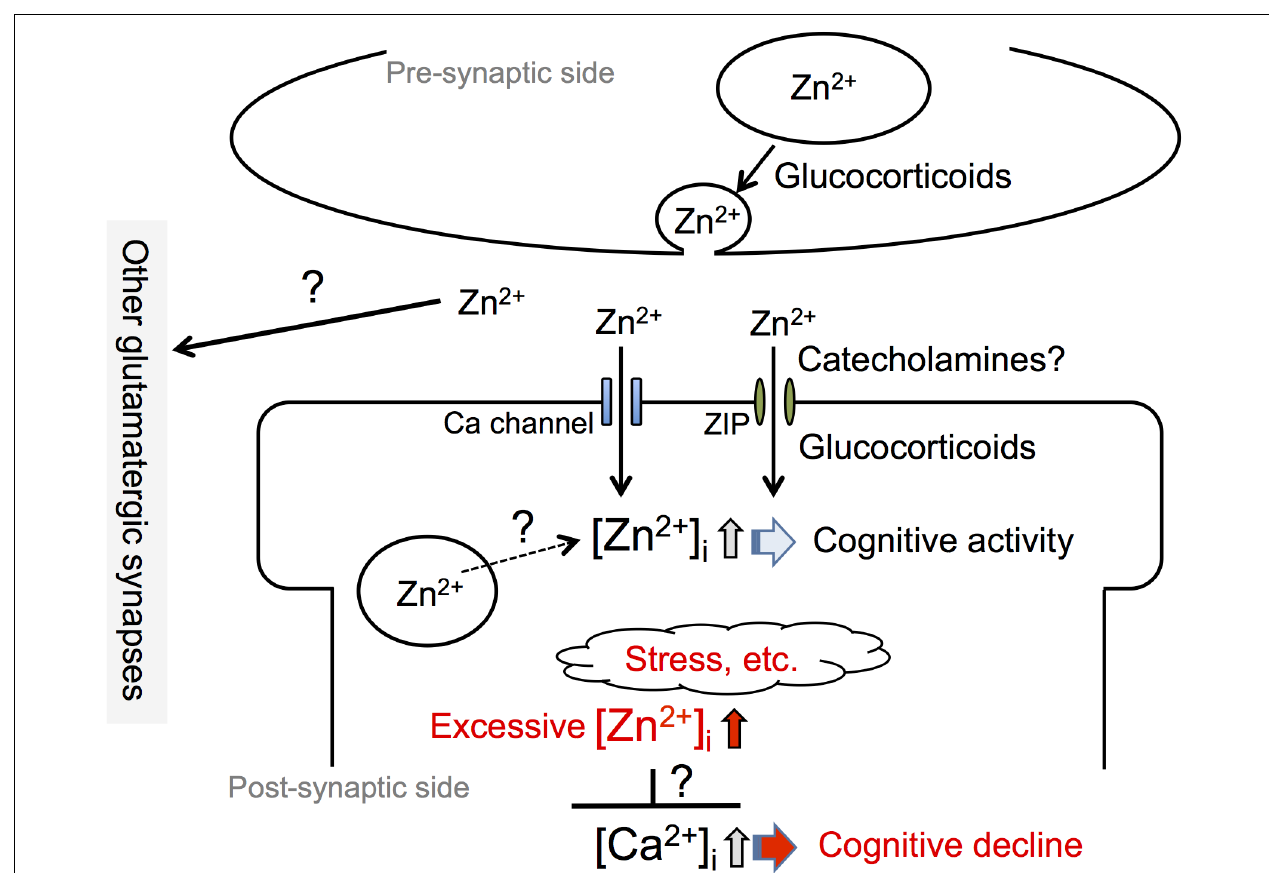
FIGURE 1 | Involvement of synaptic Zn 2+ dynamics in cognitive activity. An increase in intracellular Zn 2 + concentration, [Zn 2 + ] i , which is induced by an influx of extracellular Zn 2 + at zincergic synapses in the hippocampus, is involved in cognitive activity. Presynaptic glucocorticoid signaling, a non-genomic action, and post-synaptic glucocorticoid signaling, a genomic action, modify the degree of increase in intracellular Zn 2 + . It is